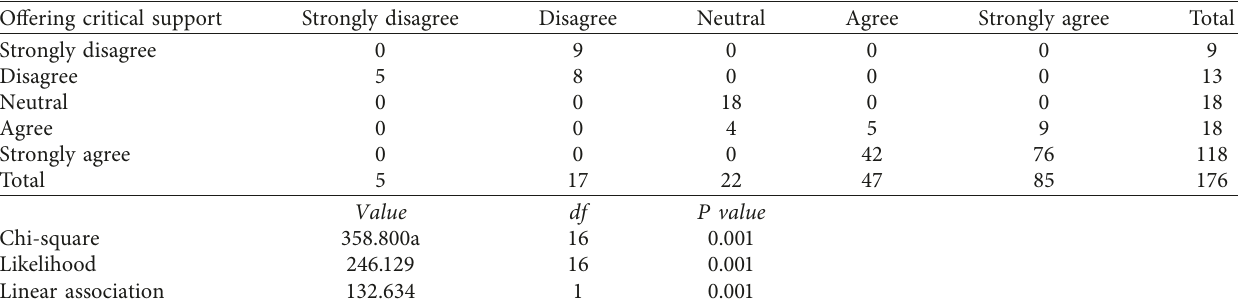
Table 5: Cross tab of offering critical support ∗ drug traceability cross tabulation.